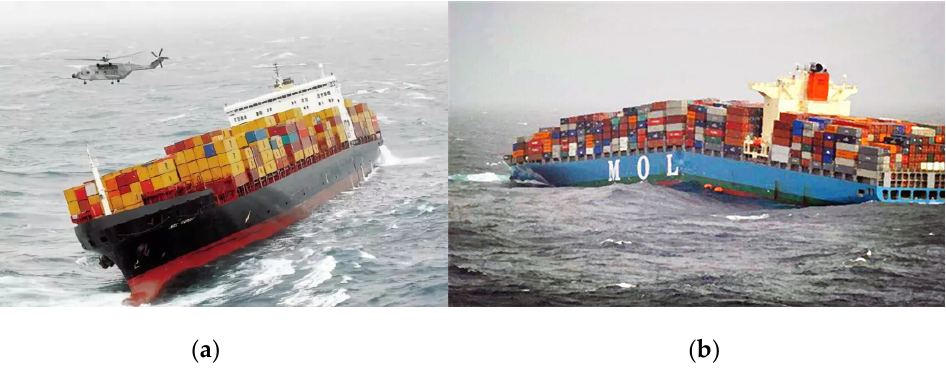
Figure 1. Severe accidents of large container ships. ( a ) MSC NAPOLI Accidents; ( b ) MOL COMFORT Accidents.